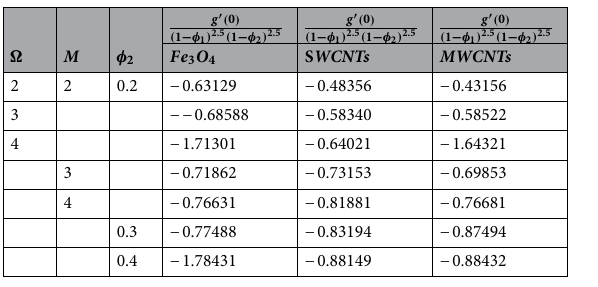
Table 4. The numerical outcomes for skin